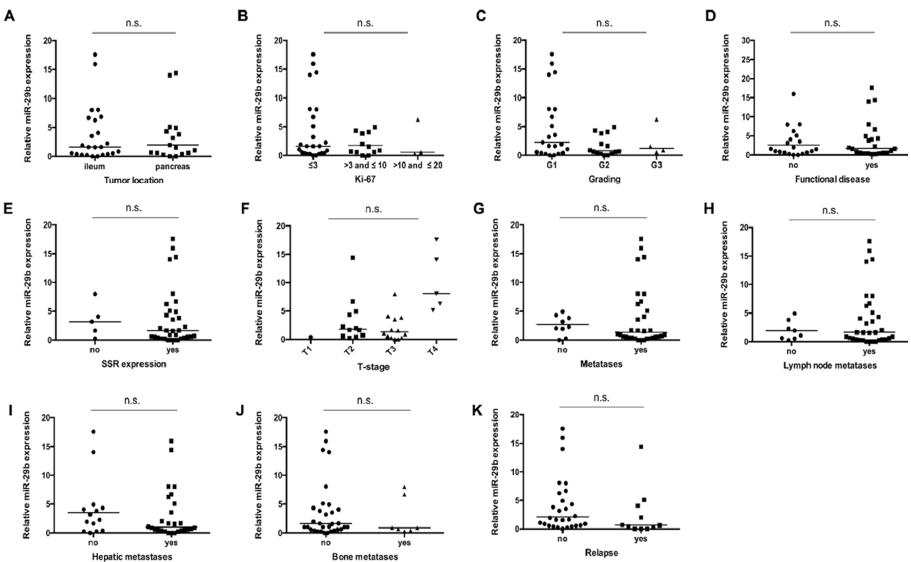
Figure 2. miR-29b expression does not reflect tumor characteristics. Analysis of miR-29 serum levels with respect to ( A ) tumor localization, ( B ) Ki-67 rates, ( C ) histological grading (Grade 1 to 3), ( D ) functional or non-functional disease ( E ) SSR expression, ( F ) T-stages, ( G ) presence of distant metastases, ( H ) presence of lymph node metastases, as well as ( I ) hepatic and (J ) bone metastases and finally ( K ) postoperative relapse status. The scatter plots display relative miR-29 expression levels between the two subgroups. The black horizontal lines represent the median per group. (* p < 0.05; ** p < 0.01; *** p <